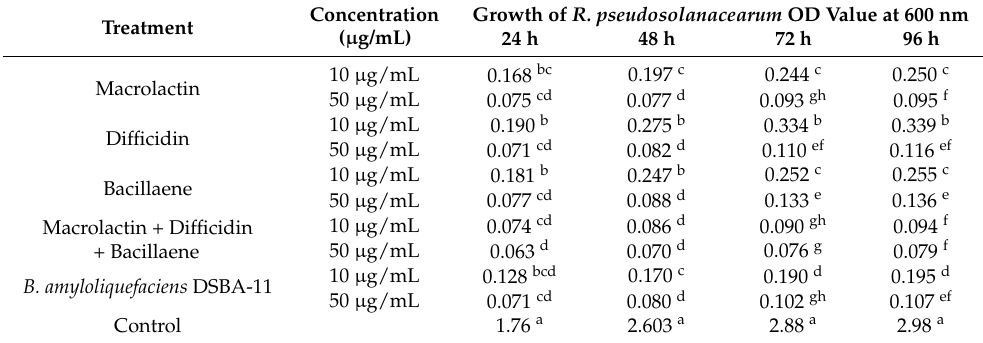
Table 5. Effect of crude ethyl acetate extracts of polyketide antibiotics of B. amyloliquefaciens DSBA-11 and its cloned product on the growth of R. pseudosolanacearum under in vitro